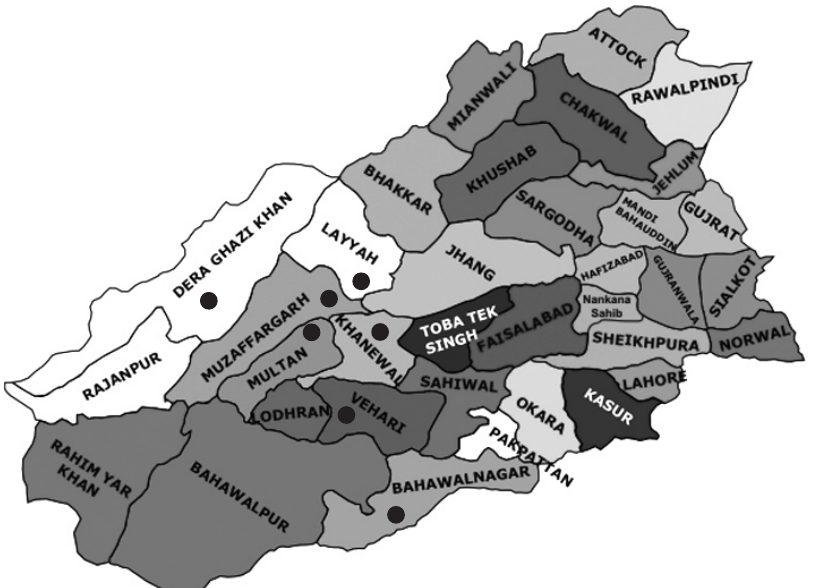
Fig 1. – Map of Punjab. Sampling sites in southern Punjab are marked with